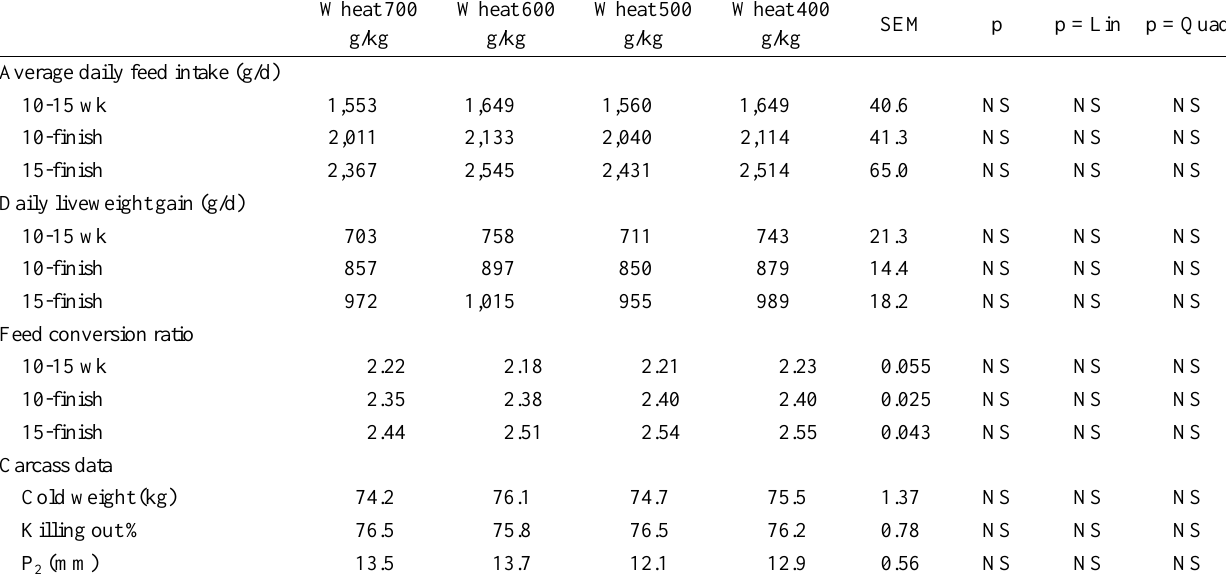
Table 3. The effect of dietary inclusion level of wheat on performance of group housed pigs